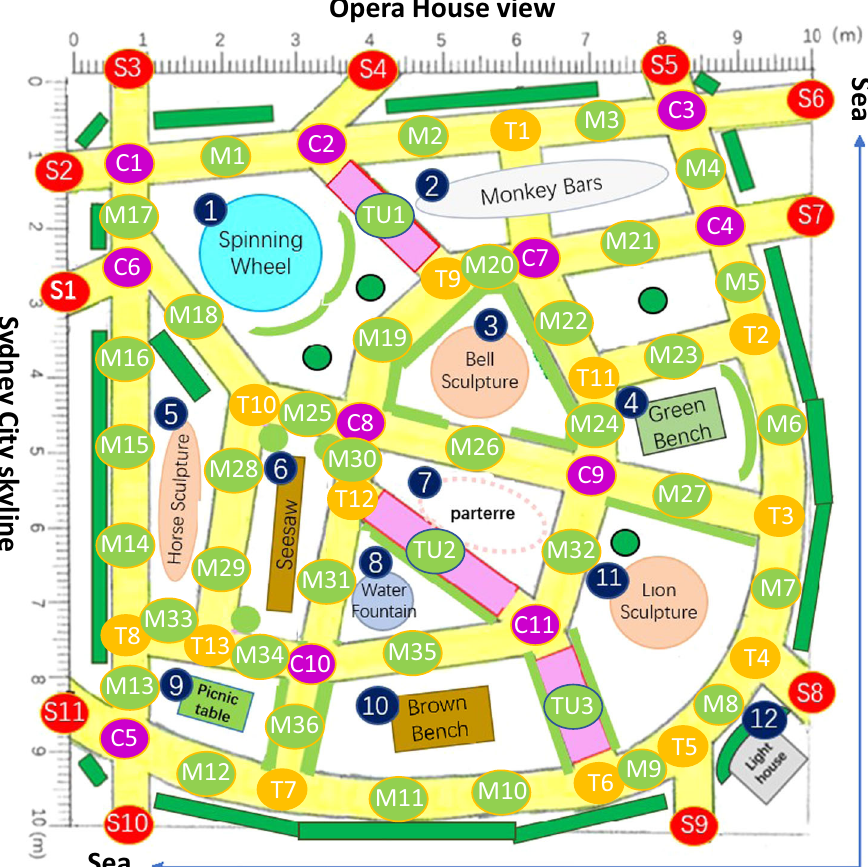
Fig. 6 Checkpoint map. The red checkpoints de fi ne the starting points; the green checkpoints are those in the middle of one path; the purple checkpoints appear at crossroads; and the yellow checkpoints represent a T intersection. The background map is a sketch of the top view of the “ Sydney Park ”